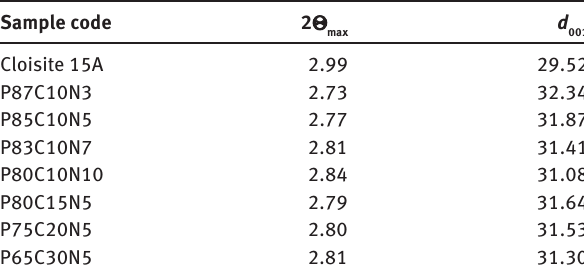
and related d -spacing for PP/PC max